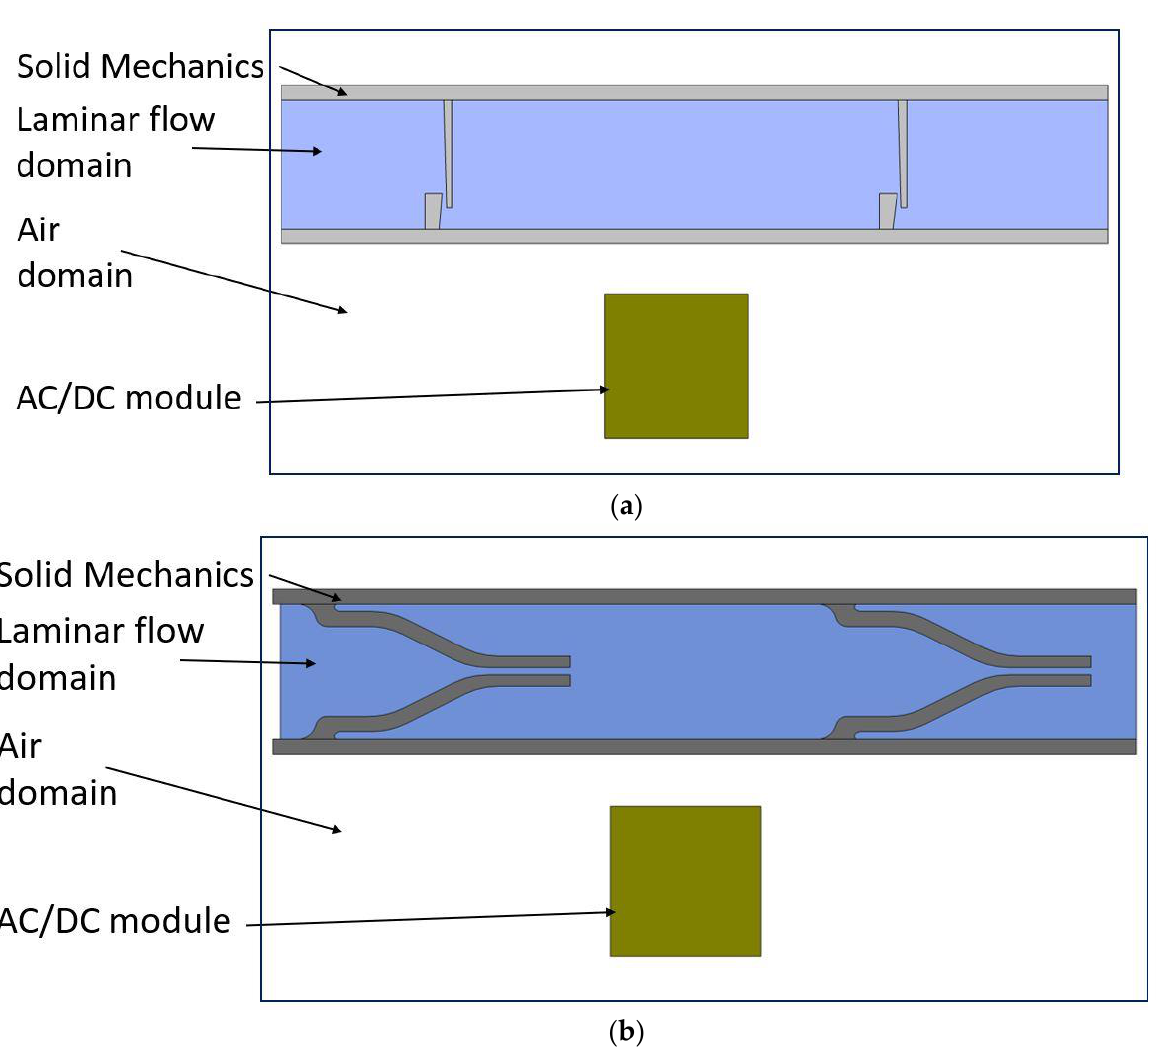
Figure 4. 2D simulation model geometries: ( a ) flap valve model; and ( b ) duckbill valve model.